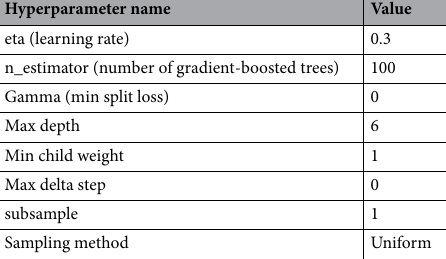
Table 3. XGBoost hyperparameter